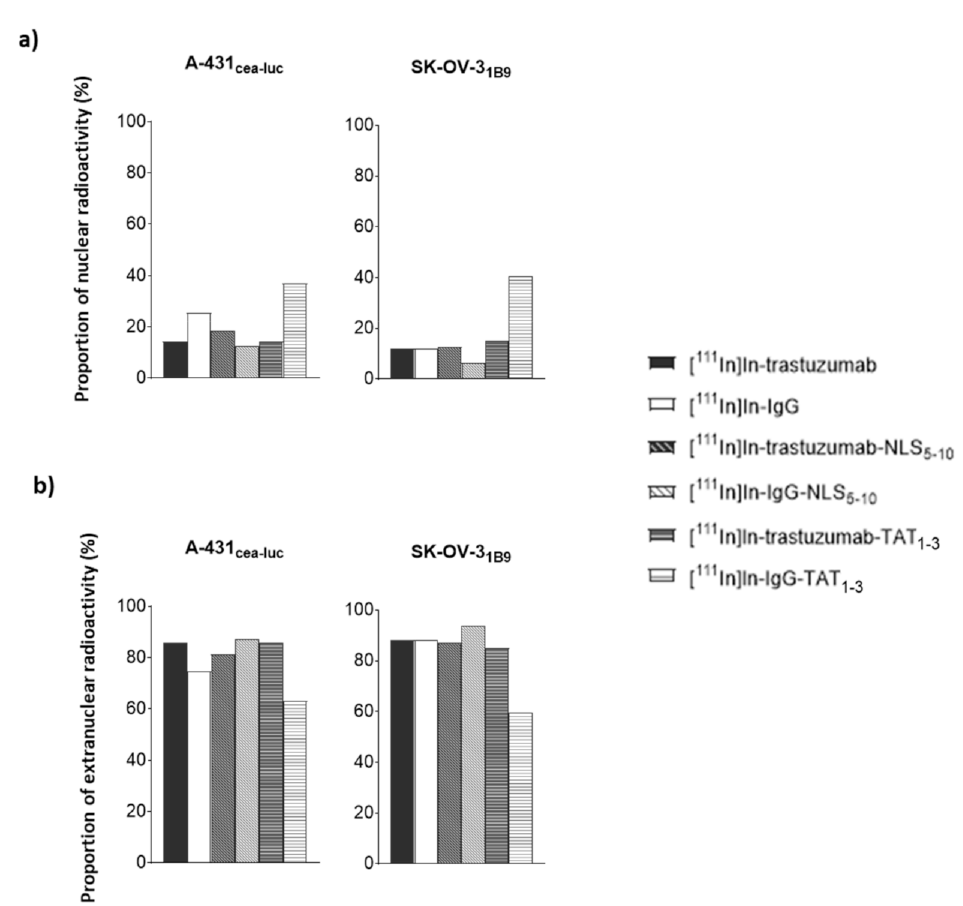
Figure 5. Percentage of: ( a ) nuclear and; ( b ) extranuclear activity. The percentage of activity in the nuclear and extranuclear fraction was calculated for each RIC based on the cumulative number of decays per cell ( Ã nuclear and Ã cellular